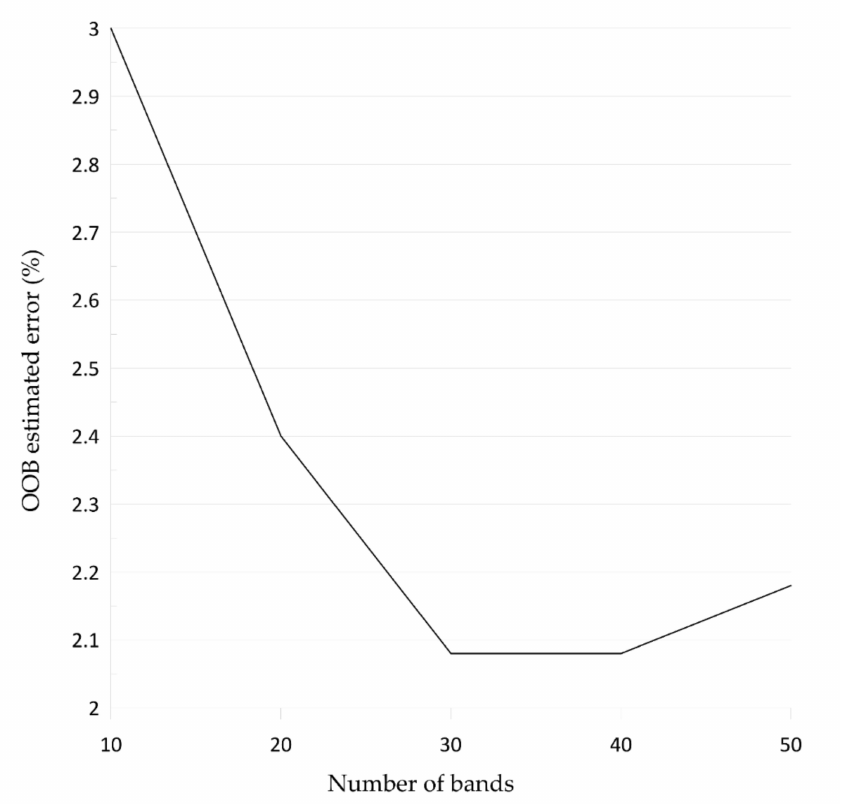
Figure 7. The results for out-of-bag (OOB) errors, using the importance of bands in separating among the studied